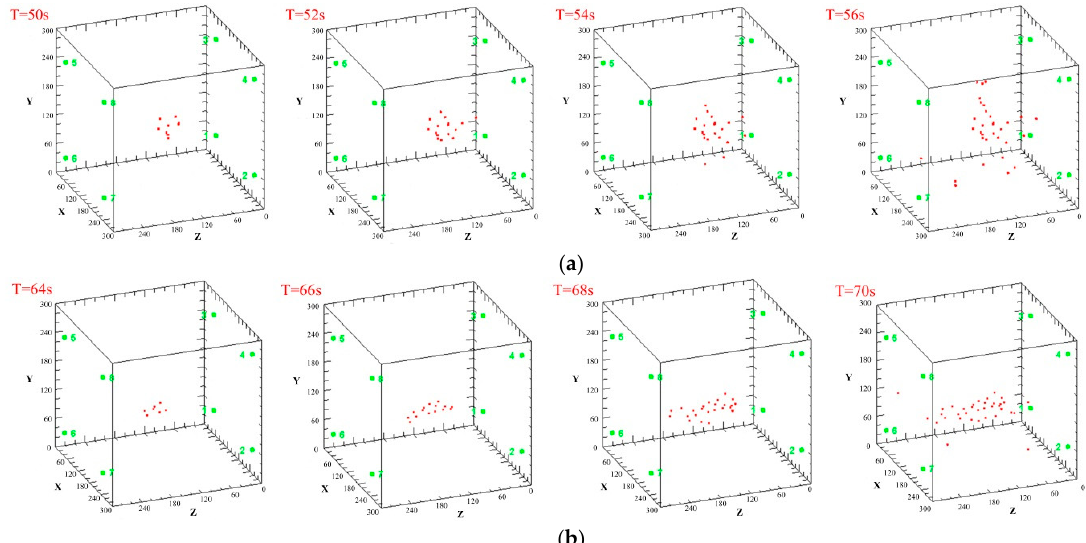
Figure 11. Block diagrams showing acoustic emission event time sequences. The block diagrams in (a) represent time progressions during the experimental run from T = 50 s on the left to T = 56 s on the right and (b) from T = 64 s on the left to T = 70 s on the right. Figure 11a shows events for a samples with φ = 20°, β = 30° , and the locations of the AE events indicate that the fractures initiated in the coal seam. Figure 11b shows a sample with φ = 20°, β = 90° , and for this sample the fractures initiated in the coal-rock interface. The green numbered dots are the locations of the AE sensors.